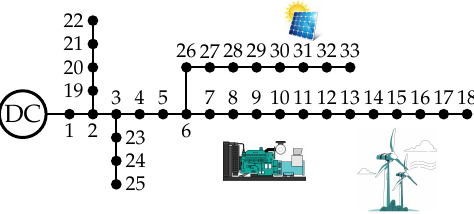
Figure 6. Modified version of the IEEE 33-bus grid for wind, diesel, PV, and